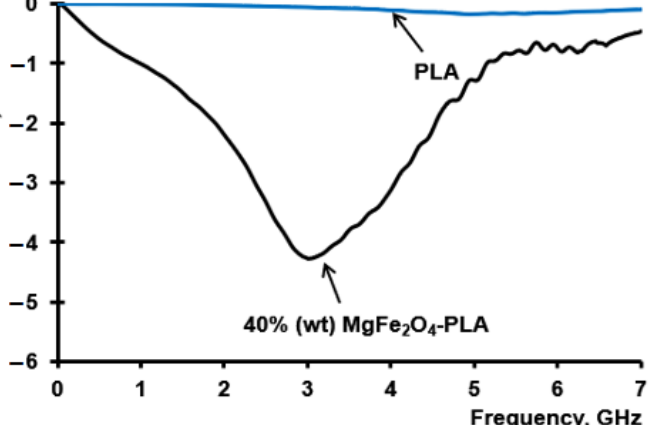
Figure 10. The measured reflection loss of 40% (wt.) MgFe 2 O 4 –PLA and pure PLA polymer FDM 3D-printed samples.